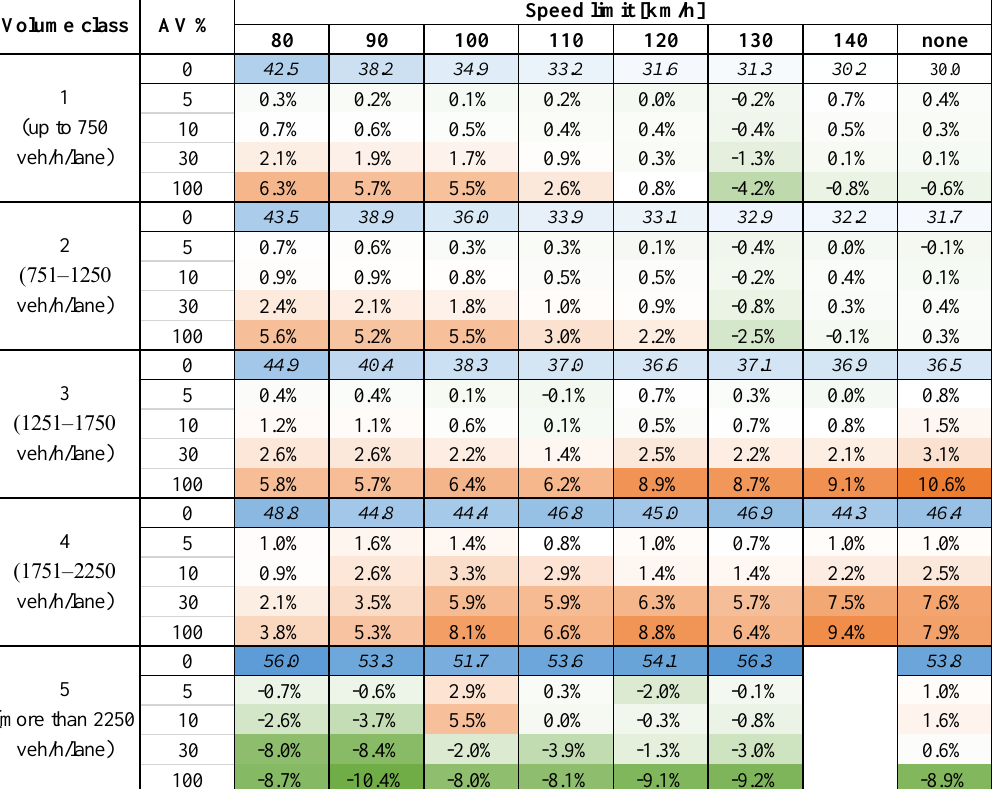
Average travel time in seconds per VKT at baseline and changes with different AV penetration rates at different speed limits and traffic